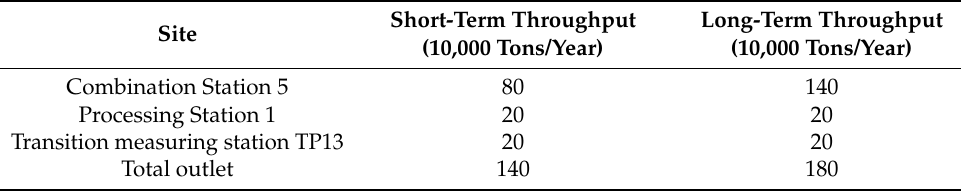
Table 1. The throughput of each station of the Shunbei crude oil pipeline.